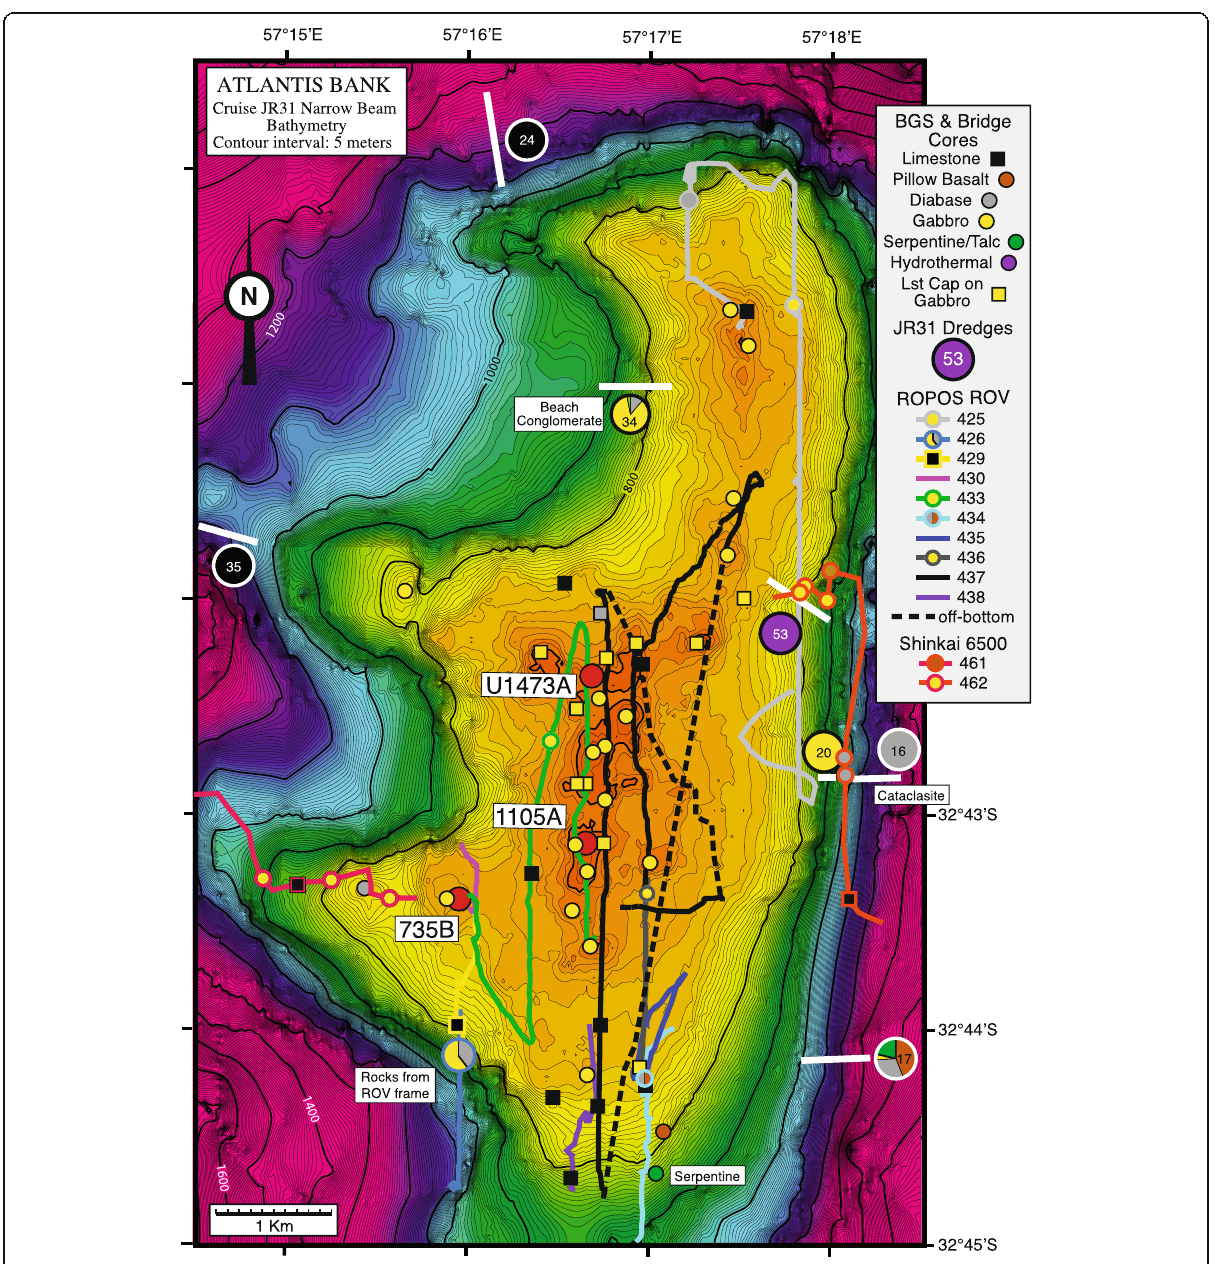
Fig. 5 High-resolution 5 m contoured narrow beam bathymetry of the Atlantis Bank wave-cut platform modified from Dick et al. (2017). ROPOS ROV dive tracks and sample locations are shown, as well as the locations of over-the-side rock drill holes and dredges as indicated in the legend. Note, as discussed in the text, the abundance of diabase compared to the ODP and IODP drill cores (9